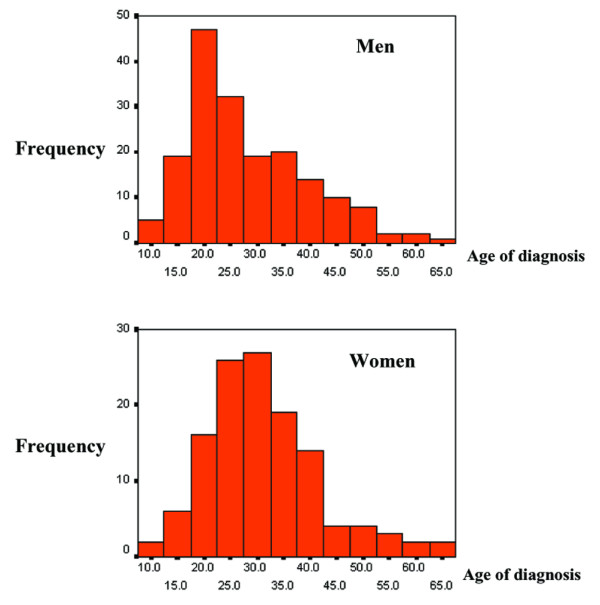
Age of diagnosis for (a) men and (b) women in the North American multiplex ankylosing spondilitis families.